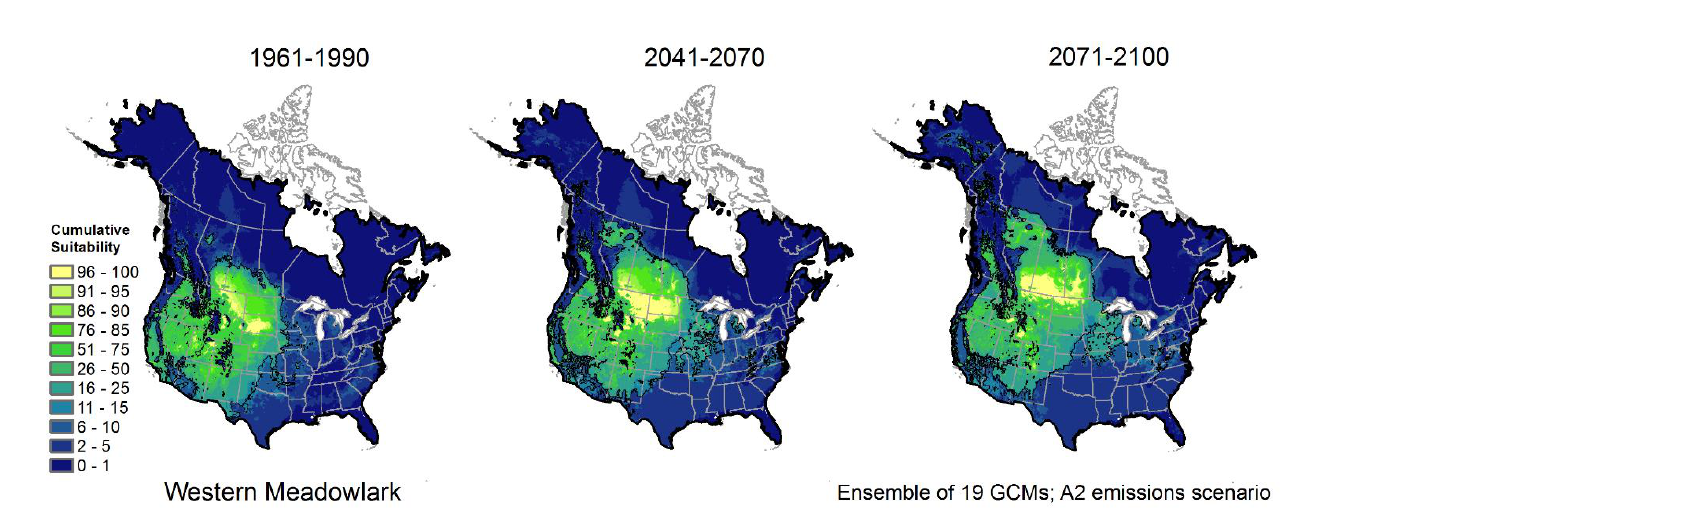
Figure A3.1. Baseline predictions (1961-1990) and future projections (2041-2070 and 2071-2100) of North American climate suitability for 15 grassland songbirds. The black line delineates core suitable climate area for each species as determined by species specific thresholds. Future projections are based on ensemble climate data from 19 global climate models and the A2 SRES emissions